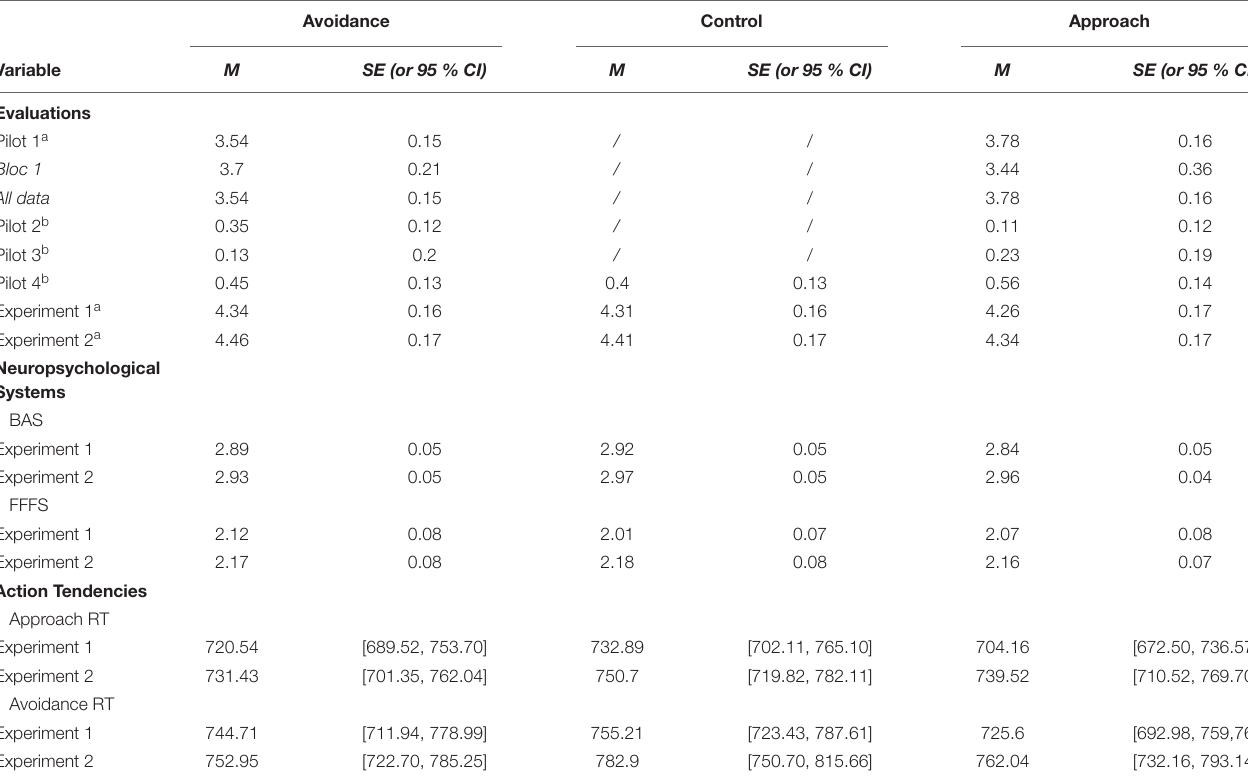
Avoidance Control